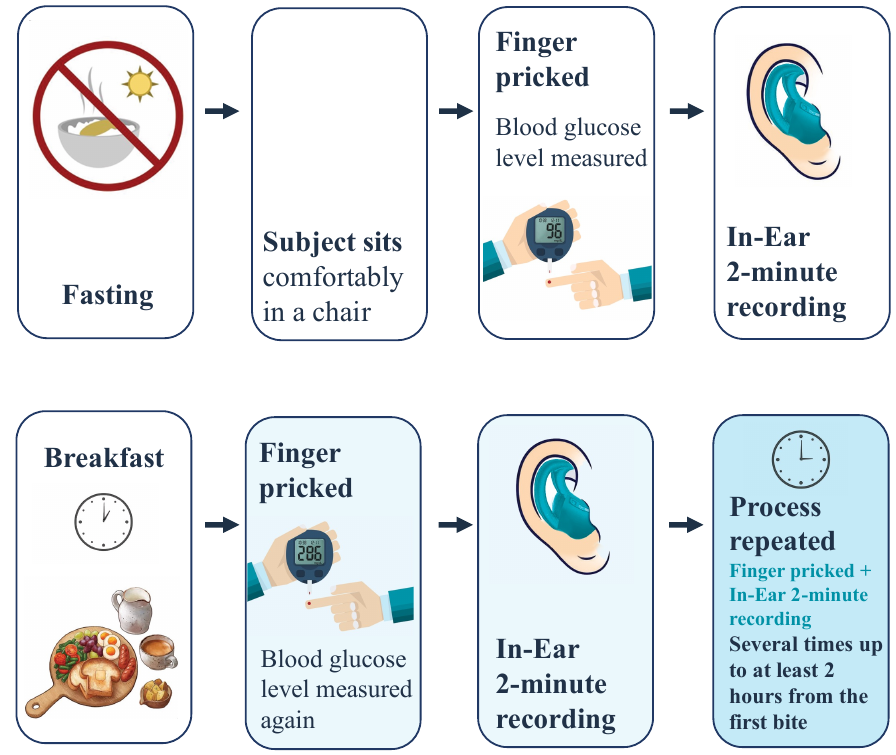
Figure 3. The recording protocol in this study. Table 1. Dataset